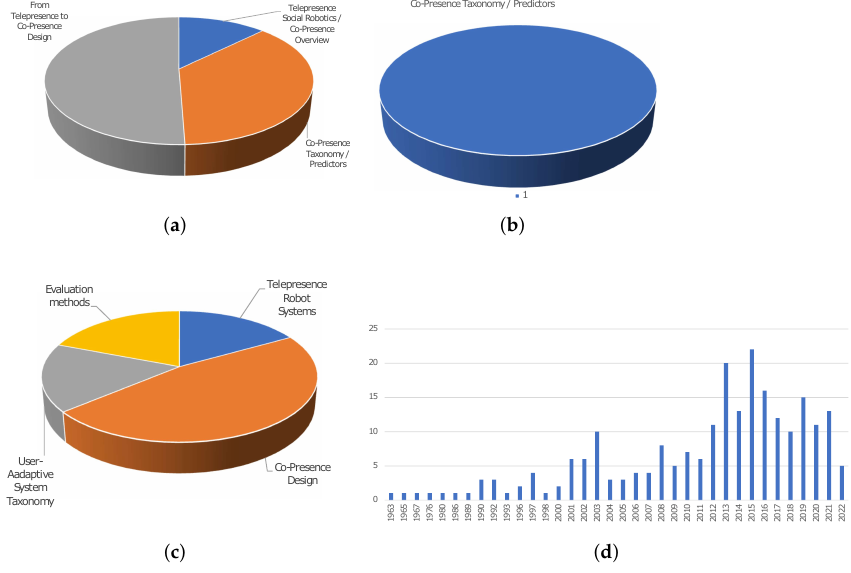
Figure 2. ( a ) Article’s citation distribution per main topic, ( b ) per Co-Presence Taxonomy / Preditors topic, ( c ) per From Telepresence to Co-Presence Design topic, and ( d ) the article’s citation distribution per